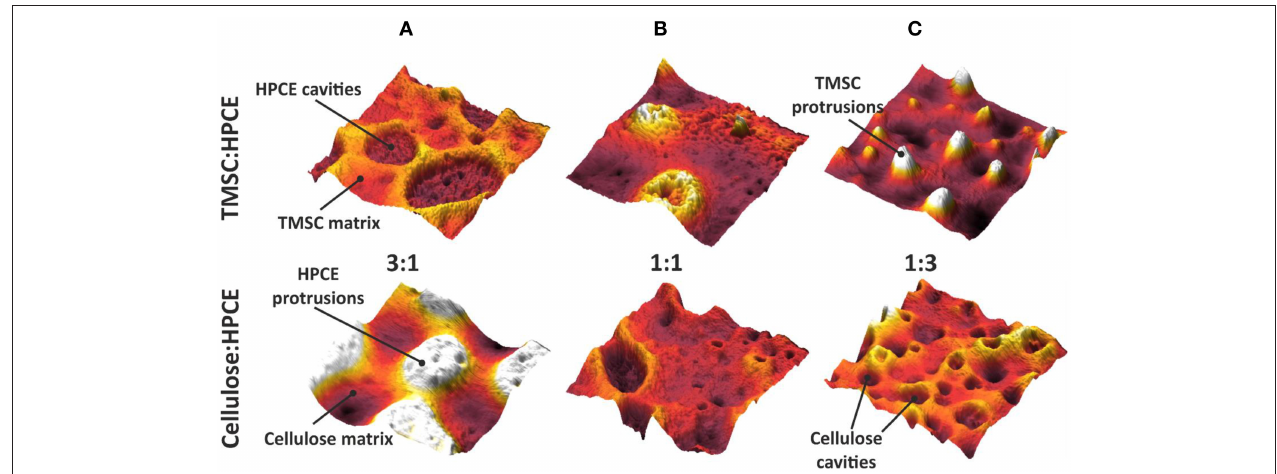
FIGURE 3 | Three-dimensional (2 µ m × 2 µ m) AFM topography images of the TMSC:HPCE (top row) and cellulose:HPCE (bottom row) blend films. (A) 3:1, (B) 1:1, and (C) 1:3. The z-scale is 60nm in all cases.